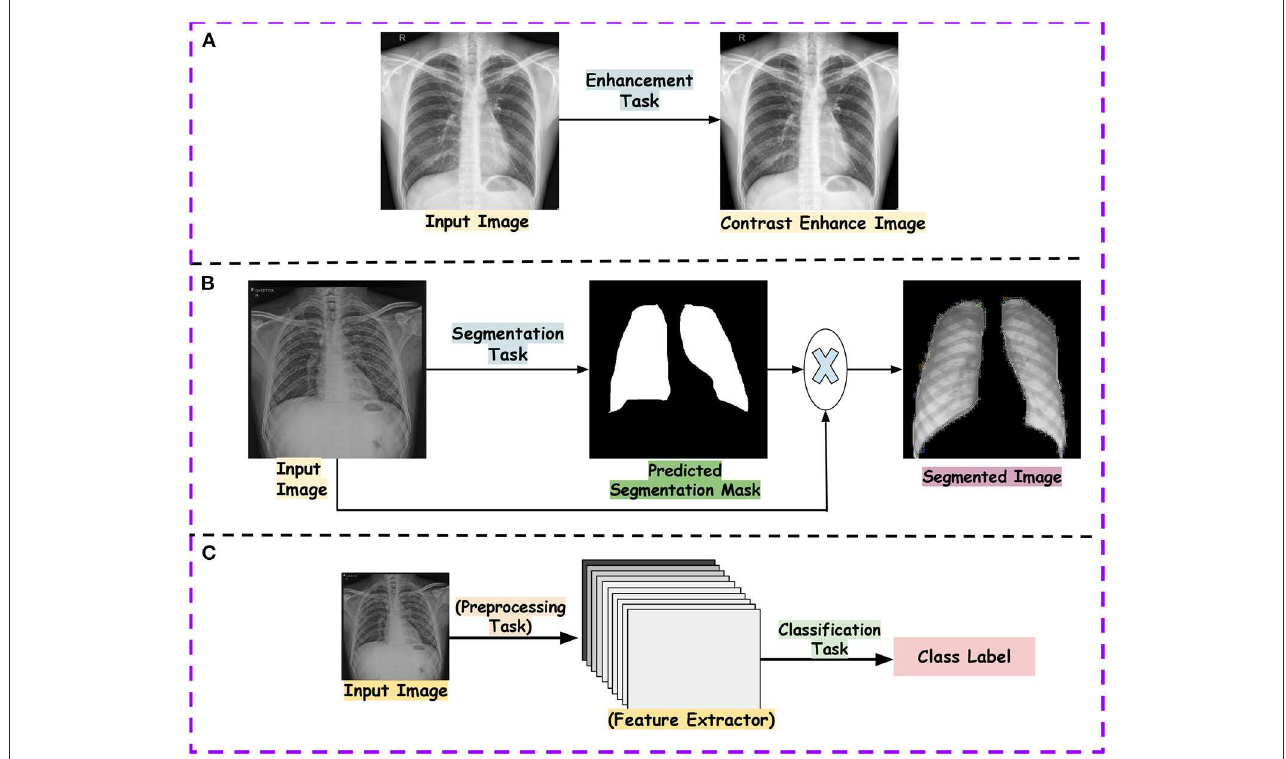
FIGURE5 Showcases the examples of outputs obtained after tasks such as pre-processing and classification. (A) shows output of contrast enhancement. (B) shows output of the segmentation task and (C) shows the classification